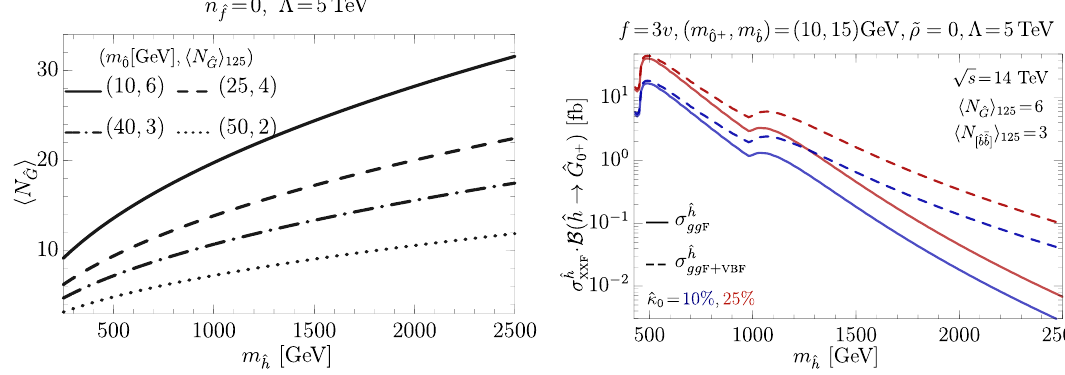
Figure 10 . The left-graph shows average glueball multiplicity h N ^ mass for di(cid:11)erent choices of the lightest glueball mass and the corresponding normalized number of glueball states at the SM Higgs mass. In the right-panel we plot cross-section times branching fraction of the heavy twin Higgs decaying to the lightest glueballs ^ G a function of the twin Higgs mass. The twin Higgs at the 14 TeV LHC is produced via gg f (solid) and gg f + vbf (dashed). We take ^ (cid:20) 0 = 10% (blue) and ^ (cid:20) 0 = 25% (red) for the lightest glueball